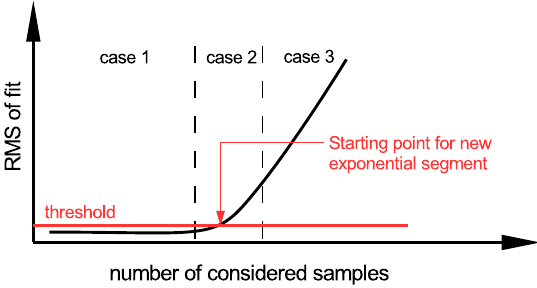
Figure 3. Determination of starting point for new exponential